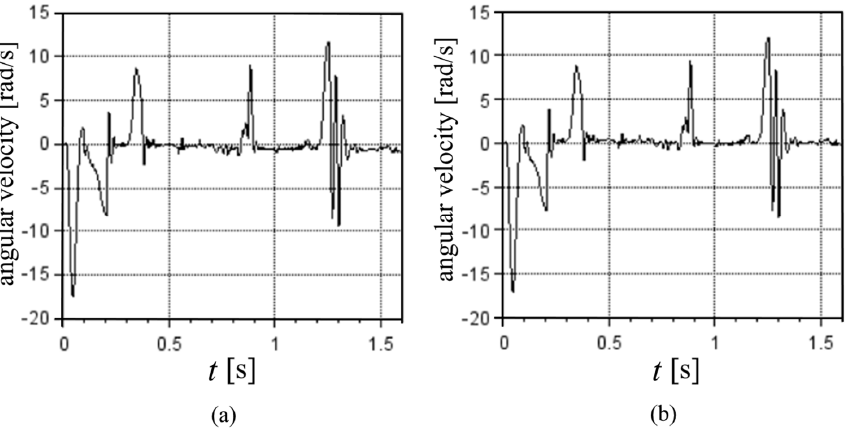
Figure 5. Angular velocity of the first cycle at 100% MS: ( a ) assuming nominal distances between accelerometer sensors and center of the nozzle, i.e., e values equal to zero. ( b ) Assuming the optimized values for e . :